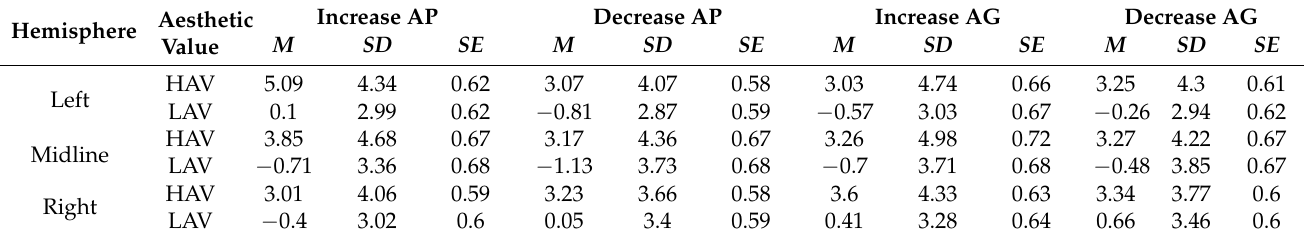
Regarding LAV, when the participants received the message of decreasing anticipated pride, the average amplitude triggered by the emotion regulation in the midline area ( − 0.71 ± 3.36 µ V) was larger than in either the left-lateralized (0.1 ± 2.99 µ V) or right- lateralized ( − 0.4 ± 3.02 µ V) area. The difference in the average amplitudes between the midline and left was significant ( p = 0.016), and the difference between the left and right sides was not significant. When the anticipants received the message of decreasing anticipated pride, the average amplitude in the midline area ( − 1.13 ± 3.73 µ V) was the largest compared to the left-lateralized area ( − 0.81 ± 2.87 µ V) and right-lateralized area (0.05 ± 3.4 µ V). The difference between the midline and the right side was significant, p <